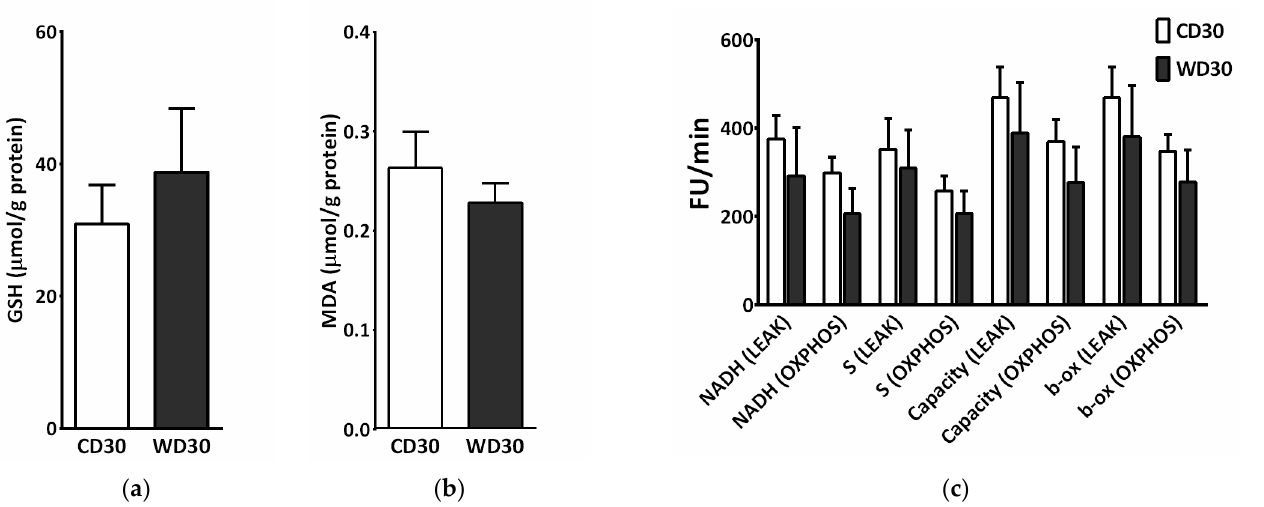
Figure 6. Parameters of liver oxidative stress in mice fed a control diet (CD30) or a Western-style diet (WD30) for 30 weeks. ( a ) Liver reduced glutathione (GSH) level. ( b ) Liver malondialdehyde (MDA) level. ( c ) Production of reactive oxygen species (ROS) in liver homogenate measured as fluorescence changes in dichlorofluorescein. LEAK, measurements in the absence of ADP; OXPHOS, measurements in the presence of ADP (2.5 mM); NADH-linked substrates (pyruvate, 5 mM; glutamate, 10 mM; malate, 2 mM); S (succinate, 10 mM); capacity (NADH-linked substrates + succinate + octanoylcarnitine, 0.5 mM + glycerophosphate, 10 mM); β -oxidation (octanoylcarnitine + malate). Results are expressed as the means ± SD (n = 6 each group).